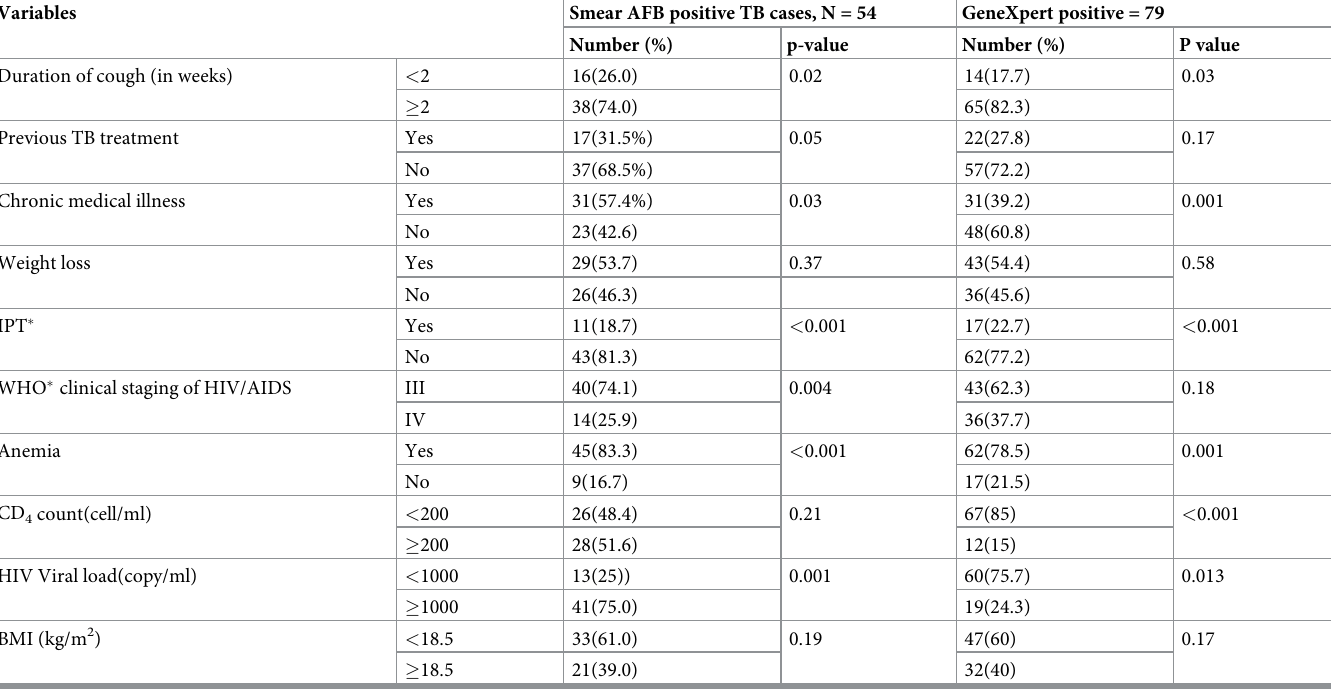
Table 3. Clinical and laboratory findings among patients with sputum AFB microscopy and GeneXpert positive results, Asella Teaching and Referral Hospital